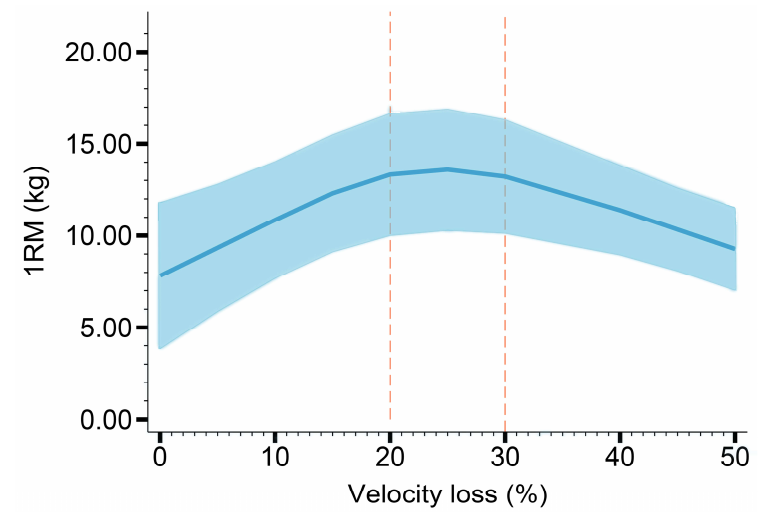
Figure 2. The dose–response curve of 1RM